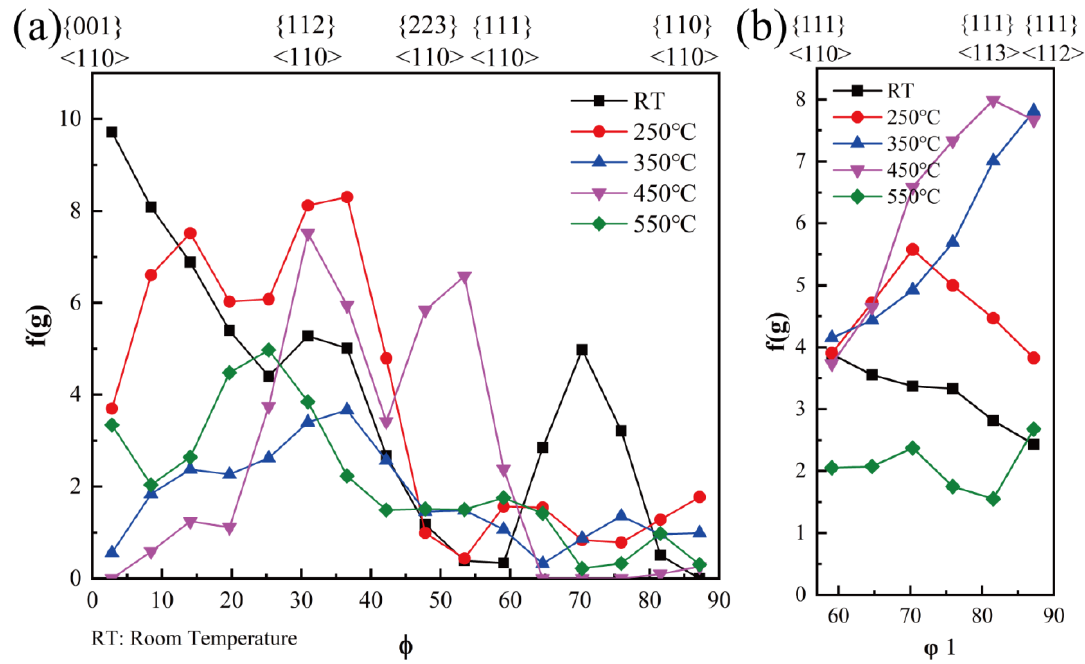
Figure 7. Orientation density after annealing: ( a ) α-orientation; and ( b ) γ-orientation.